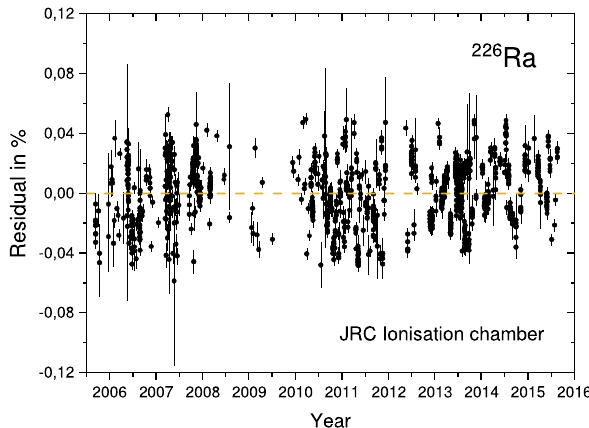
Fig. 1 Residuals in % of an exponential curve fitted to the ionisation current induced by a 226 Ra source in the IC1 ionisation chamber of the JRC, including ingrowth of decay progeny [32]. The error bars indicate sampling reproducibility only. The standard deviation of the